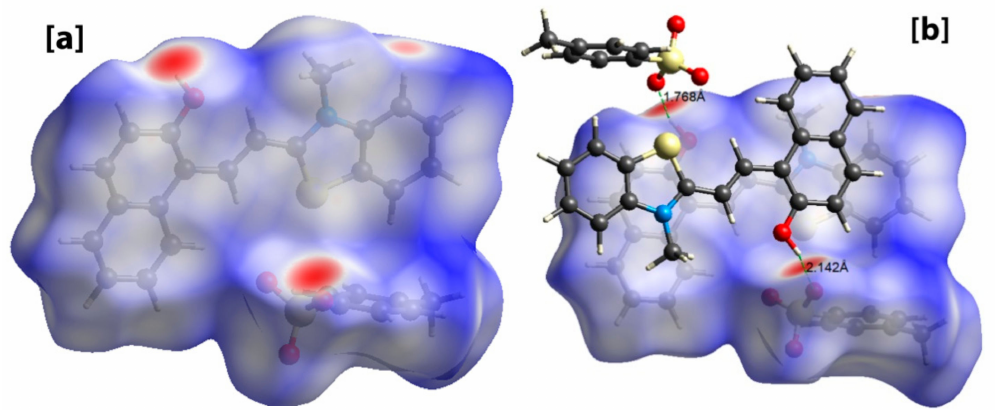
Figure 3. Hirshfeld surface analysis of 1 showing intermolecular short contacts. ( a ) Hirshfeld surface showing big red spots indicating strong intermolecular contacts, ( b ) Hirshfeld surface showing O-H ... O